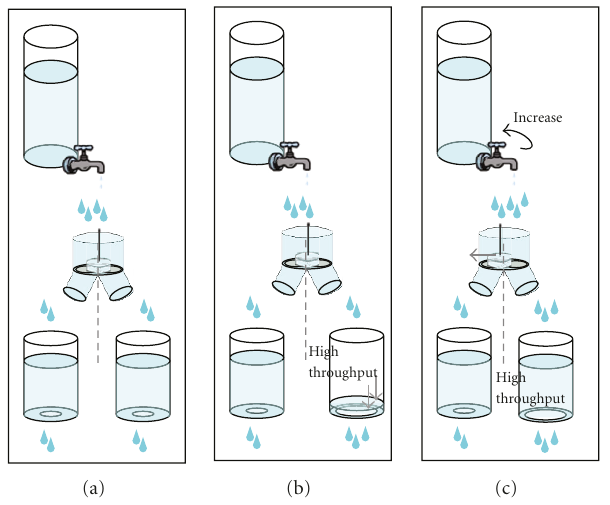
Figure 3: Representation of the TCP mechanism with parallel transmission over two